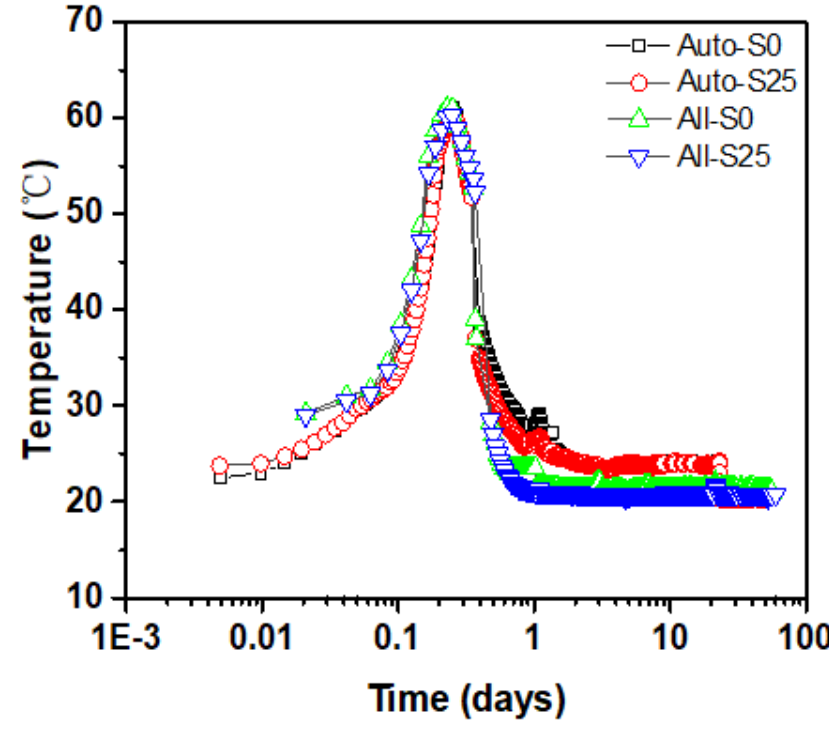
Figure 17. Temperature change inside steam-cured